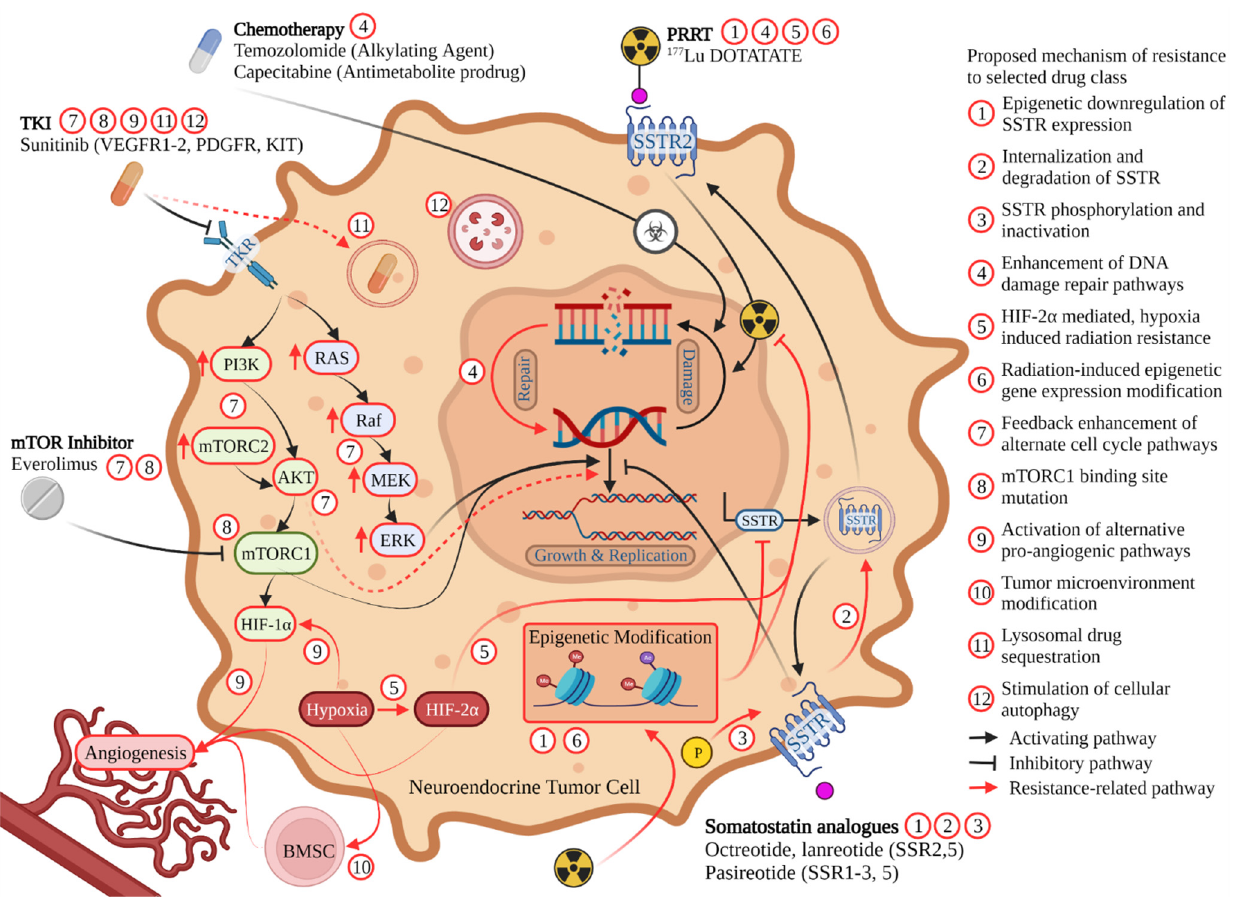
Figure 2. Mechanism of action for commonly utilized therapies for the treatment of GEP-NETs. Described mechanisms of treatment resistance are denoted by red arrows with specific resistance mechanism to each therapeutic class denoted by a corresponding numbered red circle. Abbreviations: SSTR somatostatin receptor, PRRT peptide receptor radionuclide therapy, mTOR mammalian target of rapamycin, TKI tyrosine kinase inhibitor, VEGFR, vascular endothelial growth factor receptor; PDGFR, platelet-derived growth factor receptor; KIT stem cell growth factor receptor, TKR tyrosine kinase receptor, BMSC bone marrow-derived stem cells.